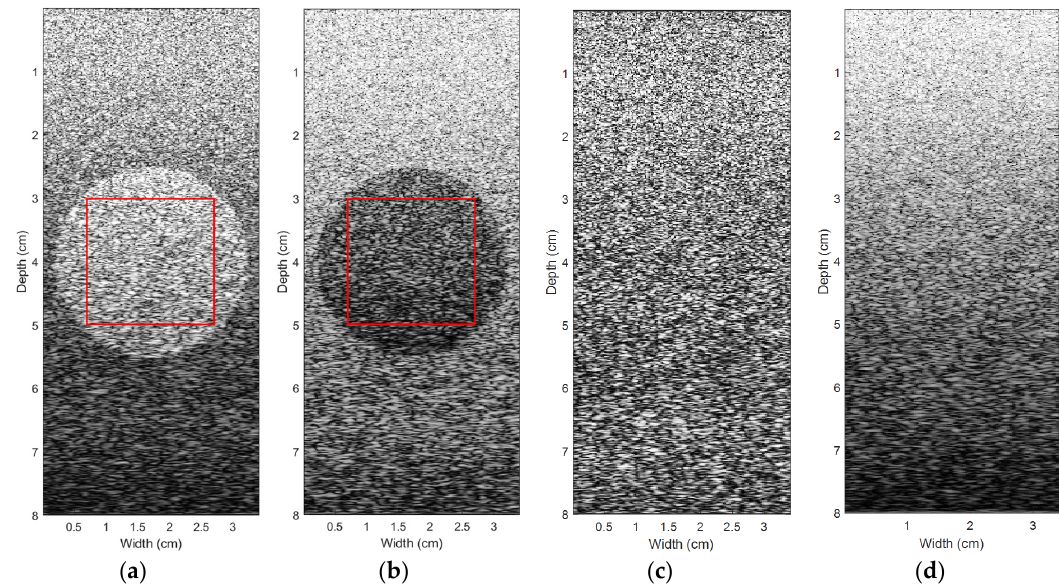
Figure 3. B-mode images of tissue-mimicking phantoms (TM) phantoms used in simulation (with region of interest (ROI) highlighted in red). ( a ) p12 sample phantom. Backscatterer intensity in cylindrical inclusion is 12 dB higher than the background. ( b ) m12 sample phantom. Backscatterer intensity in cylindrical inclusion is 12 dB lower than the background. ( c ) Reference phantom with uniform backscatterer intensity and attenuation coefficient of 0.3 dB/cm/MHz. ( d ) Reference phantom with uniform backscatterer intensity and attenuation coefficient of 0.7 dB/cm/MHz.